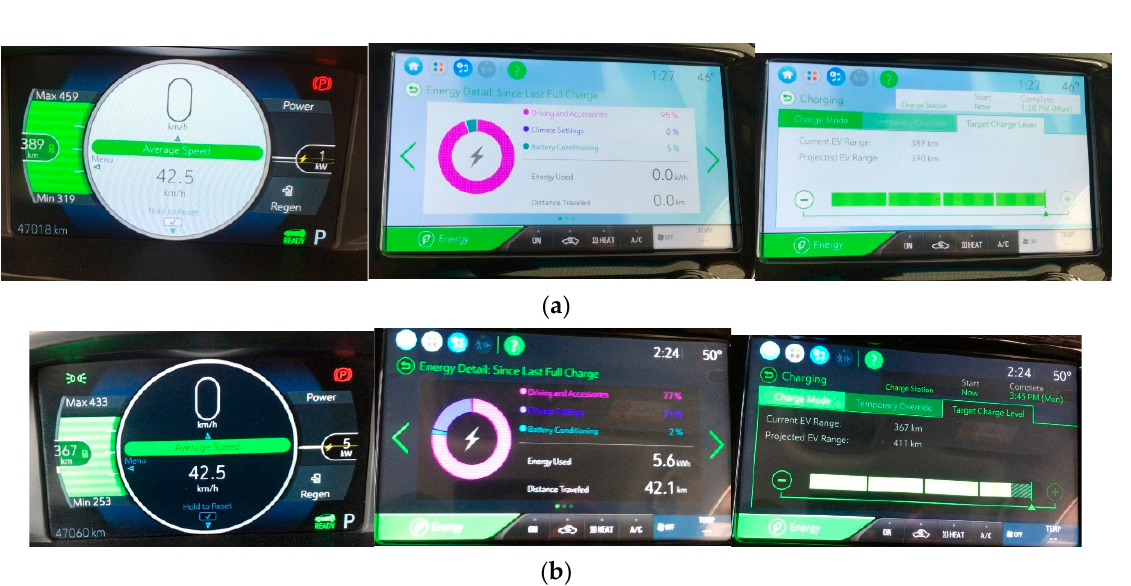
Figure 3. ( a ) Photos of dashboard at the beginning and end of the trip. ( b ) Photos of dashboard at the beginning and end of the trip.